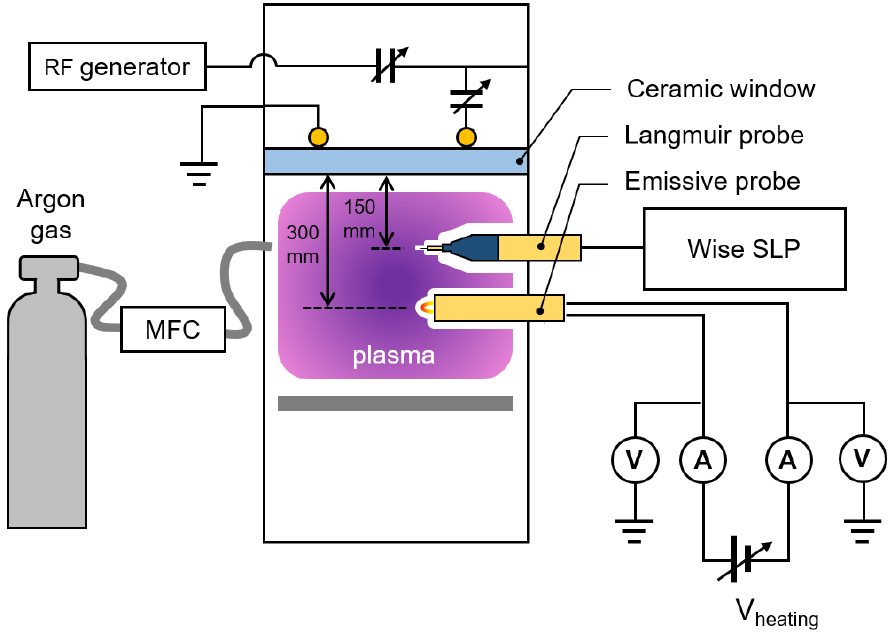
Figure 4. Schematic diagram of experimental setup for inductively coupled plasma system with an emissive probe and a Langmuir